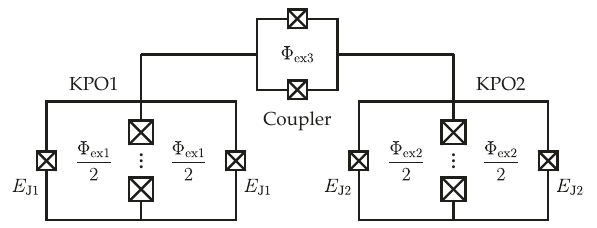
Fig. 6 Circuit implementation. Here, two KPOs are coupled via a fl ux-tunable coupler, which is a direct current superconducting quantum interference device (DC SQUID). Two large junctions with vertical dots represent a junction array. The junction capacitances and ancilla resonators are not shown for and 2b. QuTiP simulations for X gate operations are presented in Supplementary Fig. 3. The Z gate can be implemented by waiting